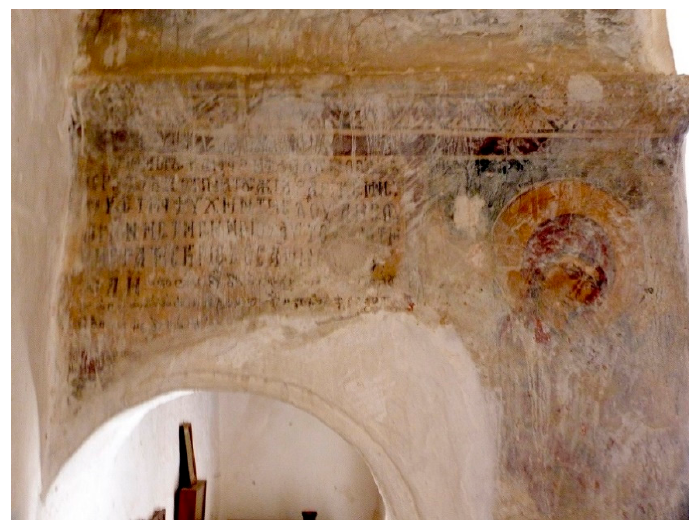
Figure 22. Dedicatory inscription (1330), Hagios Nikolaos Mavrikas (Aegina), south arm of the crossing, west wall. © Author with the permission of the Ephorate of Antiquities of Western Attica, Piraeus, and Islands. Arts 2020 , 9 , x FOR PEER REVIEW